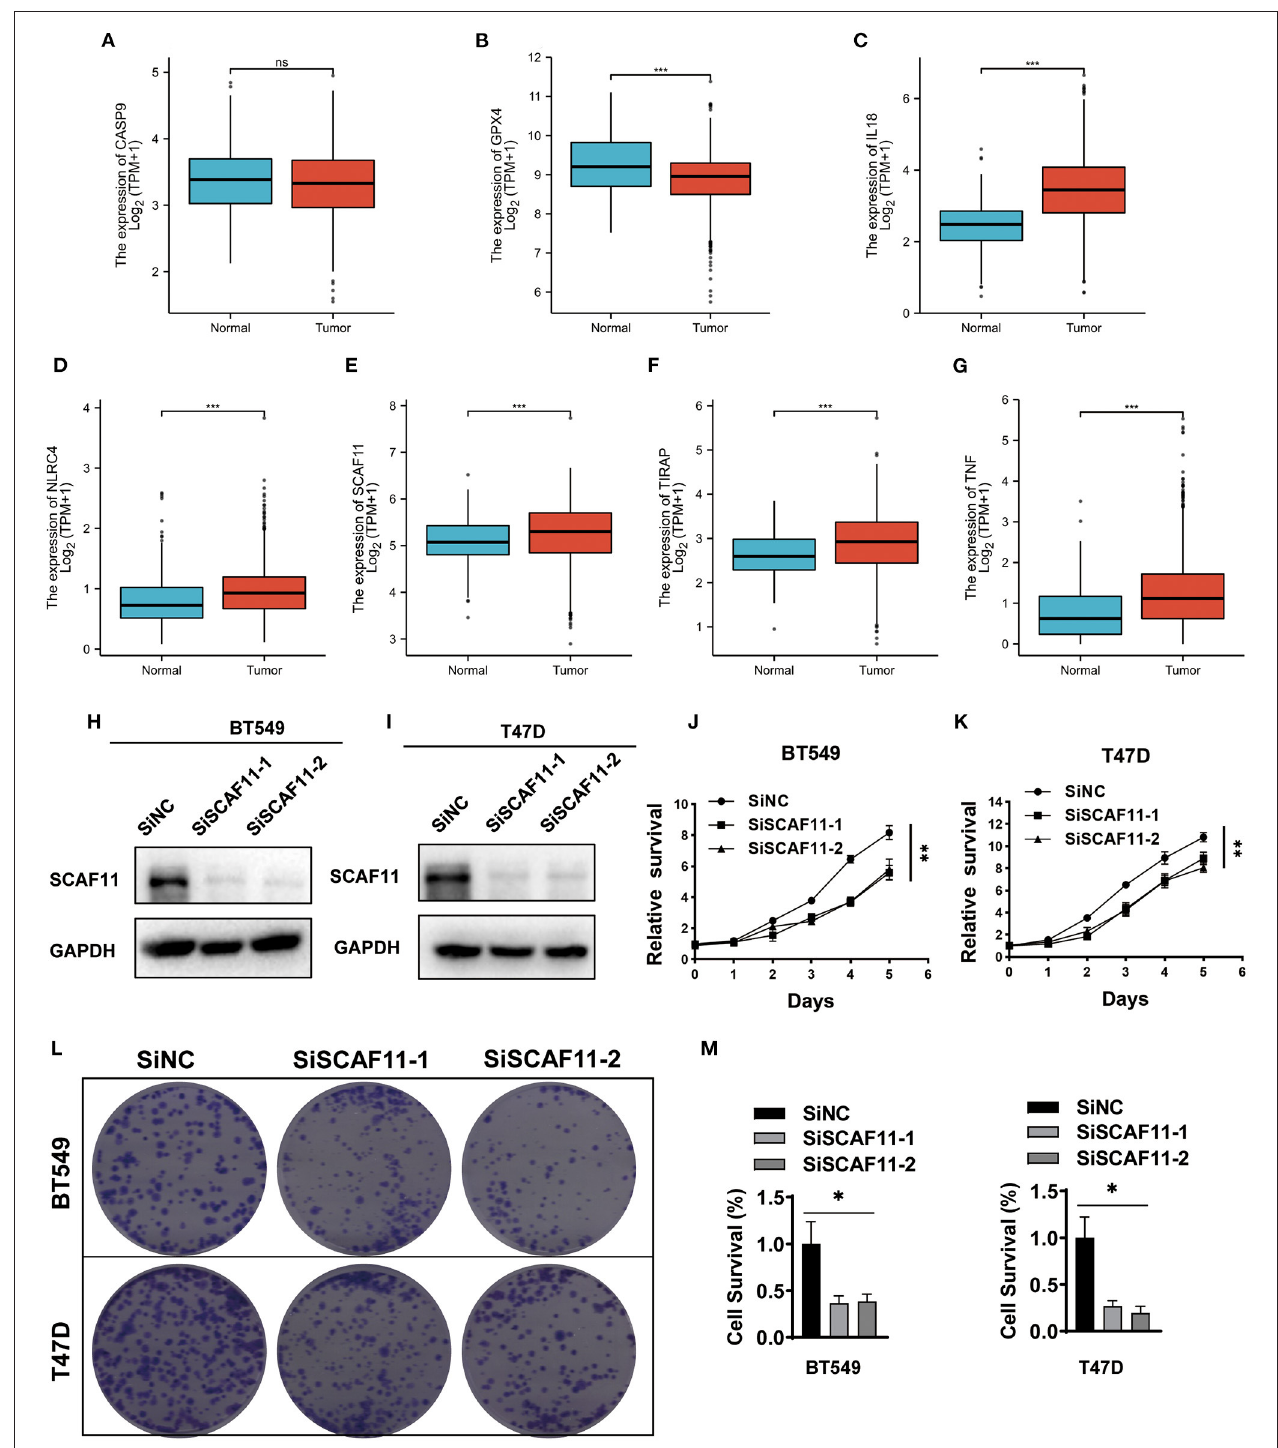
FIGURE 6 | The expression of seven pyroptosis-related genes in BRCA tissues and SCAF11 knockdown inhibited the cell proliferation. (A–G) Differential mRNA expression analysis of the seven pyroptosis-related genes in BRCA samples and normal breast tissues. The Xiantao tool was used to perform the expression profiles. (H,I) Knockdown efficacy of siRNA against SCAF11 in two human breast cancer cell lines, BT549 and T47D, was analyzed by western blotting. (J,K) CCK-8 assay indicated the effects of SCAF11 knockdown on cell proliferation rate of BT549 and T47D. (L,M) SCAF11 knockdown inhibited the cell colony formation rate in BT549 and T47D cell lines. * p < 0.05, ** p < 0.01, *** p < 0.001, ns: no statistical significance.